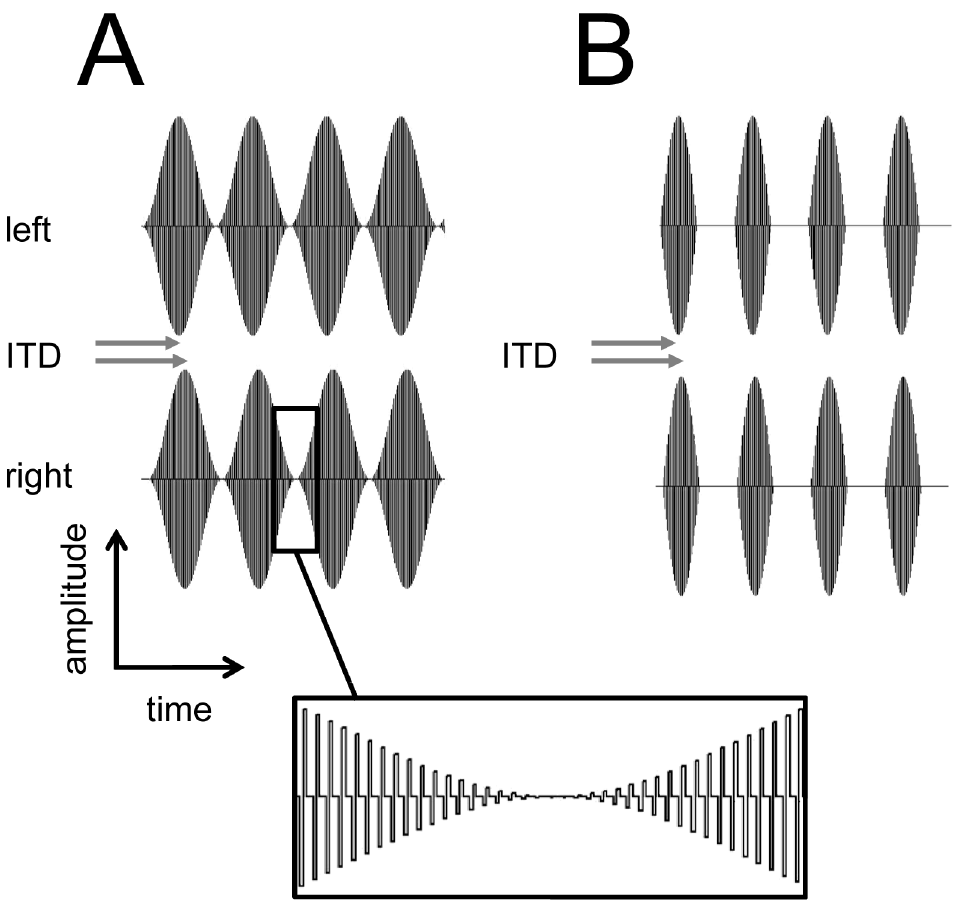
Figure 3. Electrical stimuli presented to deaf animals with cochlear implants. Time waveforms of the electrical stimuli that were presented, including SAM (A) and HWR biphasic-pulse trains (B). The box shows a segment of the stimulus envelope and fine structure in more detail.